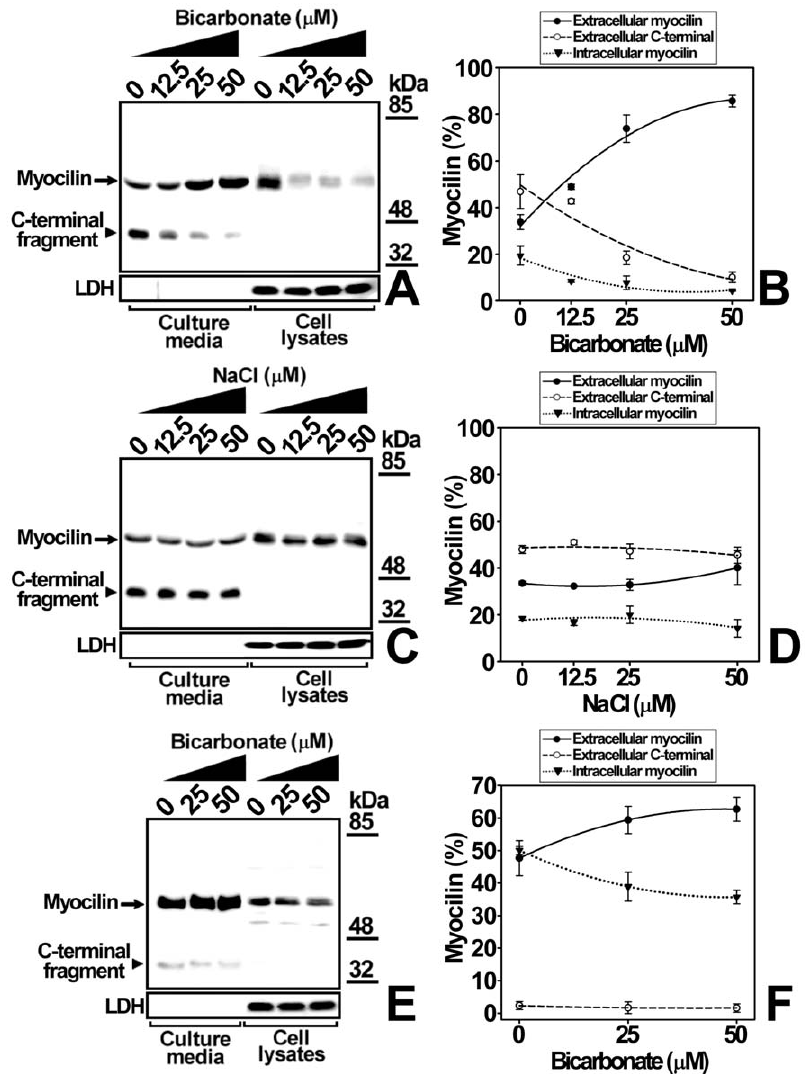
Figure 10. Specificity of extracellular bicarbonate effect on myocilin secretion. HEK-293T cells (400000 cells/well) were transfected with a cDNA construct encoding myocilin-myc. After transfection the cells were incubated in DMEM for 48 h with increasing concentrations of either sodium bicarbonate (A) or control NaCl (C). Recombinant myocilin was analyzed both in the culture medium and cells by 10% polyacrylamide SDS- PAGE and Western blot using an anti-myc monoclonal antibody. Cell lysates and culture medium samples contained 20 and 80 m g of total protein, respectively. As an internal control of sample loading or cell integrity LDH was detected in cell extracts and culture media, respectively, using a goat anti-LDH antibody. (B) and (D) quantitation by densitometry of recombinant myocilin detected in A and C, respectively. (E) The human ocular cell line hCM stably expressing recombinant myocilin-HA (400000 cells/well) was incubated with increasing concentrations of sodium bicarbonate as indicated in A. Recombinant myocilin and LDH were also analyzed as indicated in A using anti-HA and anti-LDH monoclonal antibodies, respectively. (F) Quantitation by densitometry of recombinant myocilin detected in E. Error bars correspond to the SD of three independent experiments carried out in triplicate. One-way ANOVA analysis for extracellular full-length myocilin, extracellular C-terminal fragment and intracellular myocilin in B, p , 0.001, p , 0.05 and p , 0.01, respectively. One-way ANOVA analysis in D, p . 0.5. One-way ANOVA analysis for extracellular full-length myocilin, extracellular C-terminal fragment and intracellular myocilin in F, p , 0.05, p , 0.01 and p . 0.05,